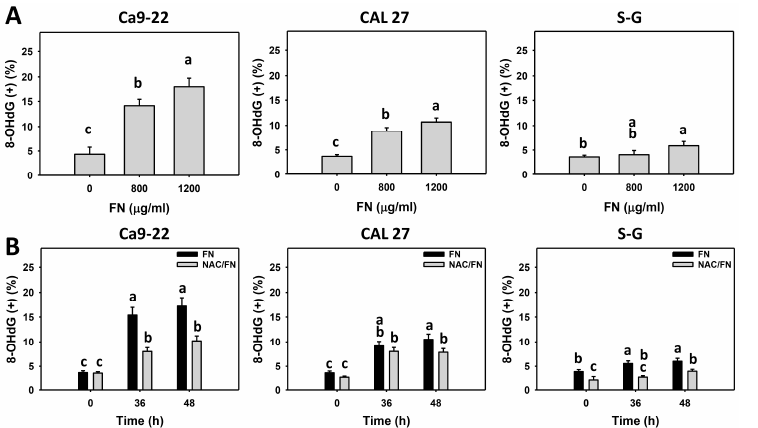
Figure 9. Fucoidan increases the 8-OHdG level of oral cancer cells. Summary histograms of the flow cytometry results are presented. The individual density plots are presented in Supplementary Figure S4. ( A ) 8-OHdG statistical analysis. Oral cancer (Ca9-22 and CAL 27) and non-malignant cells (S–G) were treated with fucoidan (control, 800, and 1200 μg/mL) for 0 and 48 h. (+) indicates a high level of 8-OHdG. ( B ) The effect of oxidative stress on the 8-OHdG increment in fucoidan-incubated oral cancer cells. After NAC preincubation or not, cells were treated with fucoidan (1200 μg/mL) with NAC co-treatment (10 mM) for 0, 36, and 48 h. NAC/fucoidan (NAC/FN) represents the pretreatment with NAC and post-treatment with FN. Data = mean ± SD ( n = 3 experiments). Data with non-overlapping letters reveal significant differences ( p < 0.05). In the example of Figure 9B (Ca9-22 cells), FN at 0 and 36 h, labeled with the connecting letters “c and a”, has significant results, because the letters do not overlap. FN and NAC/FN at 36 or 48 h labeled with “a and b” have significant results. In contrast, FN at 36 and 48 h labeled with “a” has nonsignificant results because they overlap with “a”. The positive control of 8-OHdG is provided in Supplementary Figure S10.